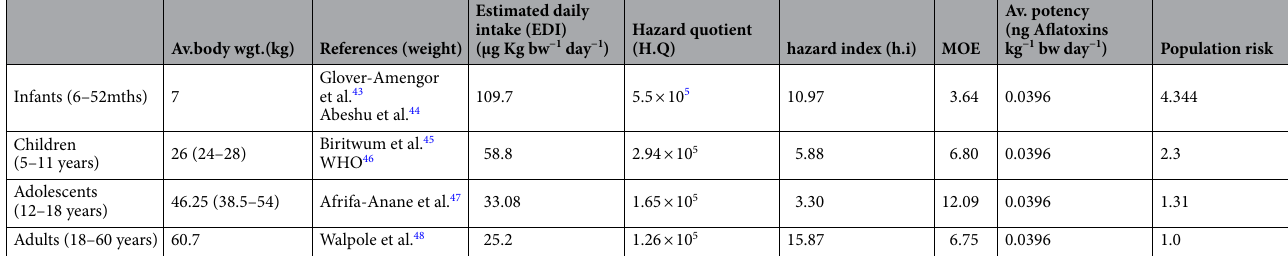
Table 9. Evaluation of risk for Total Aflatoxins via consumption of maize. Margin of Exposure-MOE. *Mean aflatoxins-36.13 µg kg −1 . *Daily intake of maize for infants was halved (0.5 × 42.5 kg). *Daily intake of 42.5 kg was used for children, adolescents, and adults. TD 50 = 0.2 ng Kg bw −149 . 1 ng = 0.001 μg.